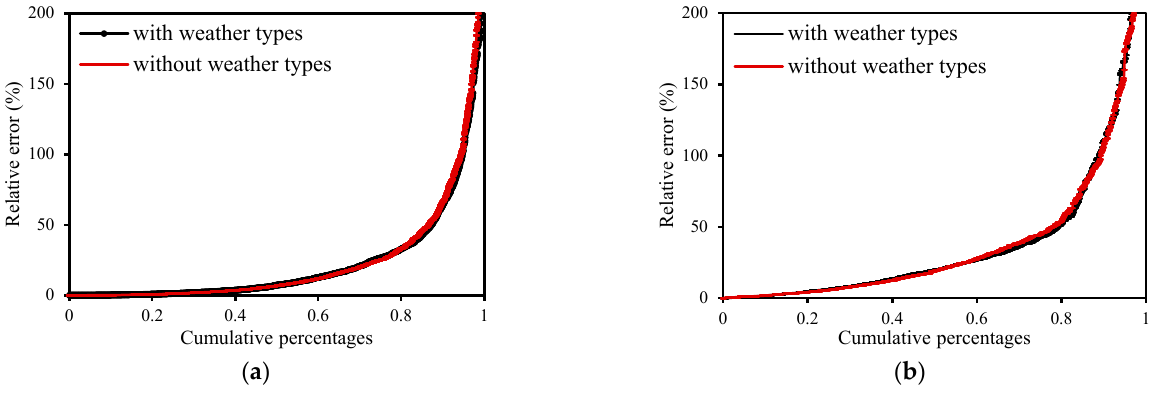
Figure 11. Probability cumulative curve of the LightGBM model with and without weather types. ( a ) Training set. ( b ) Testing set.